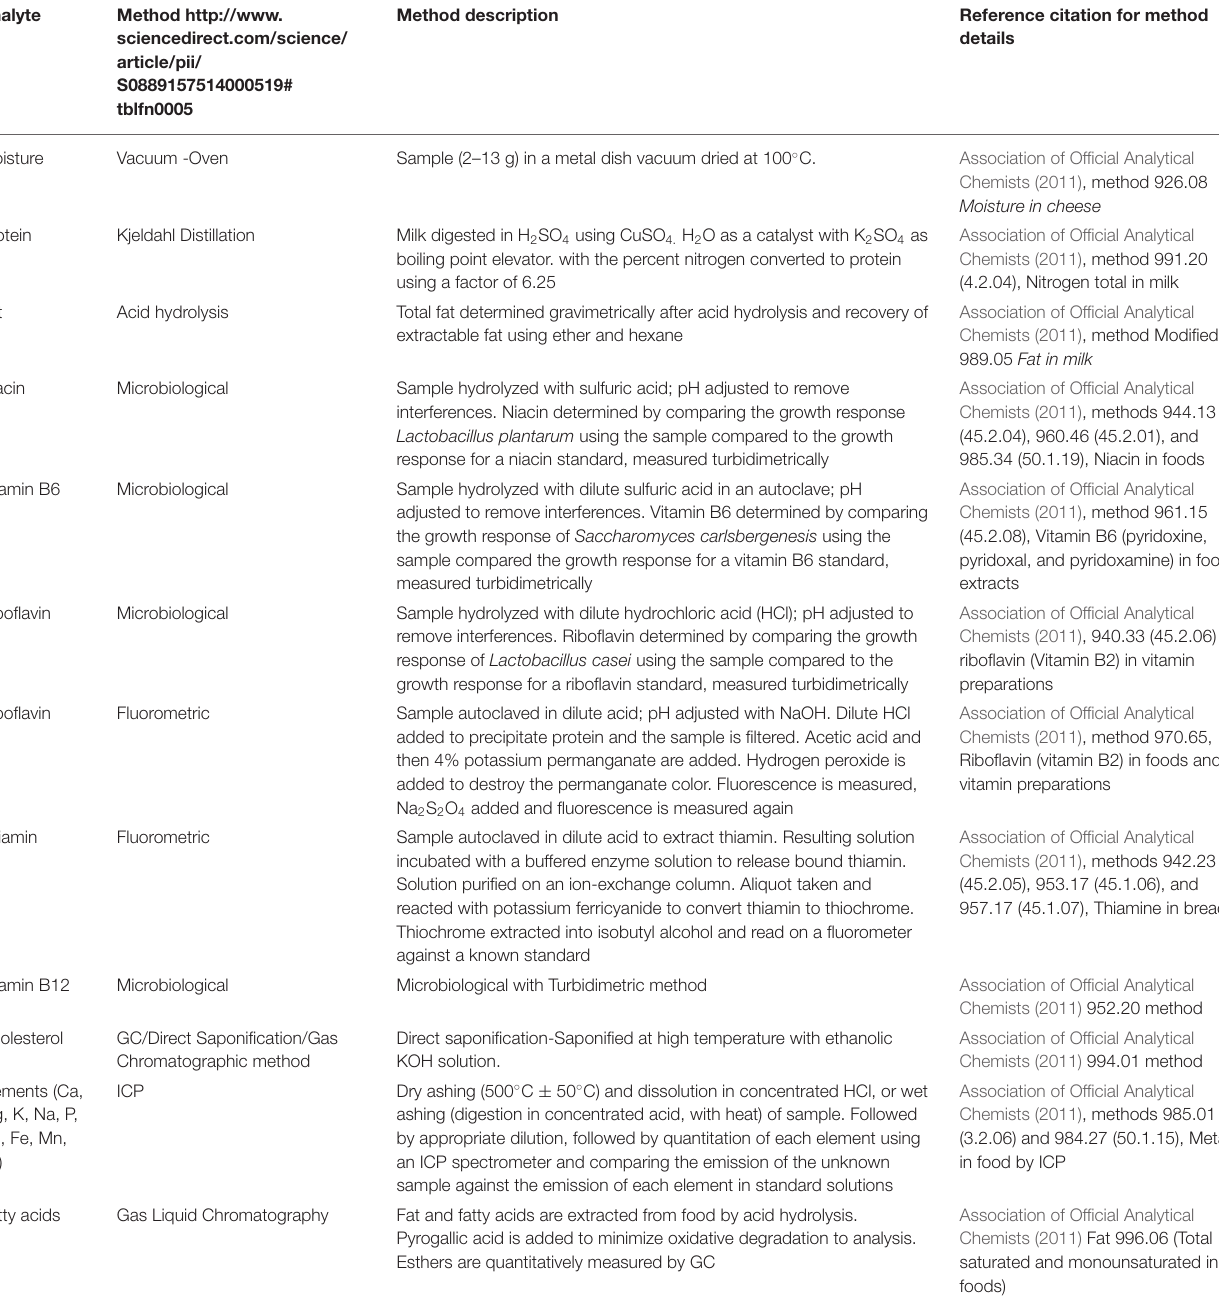
TABLE 2 | Assay methods used for nutrient analyses of Ruffed Grouse collected in New York, Minnesota, and Vermont, 2012.